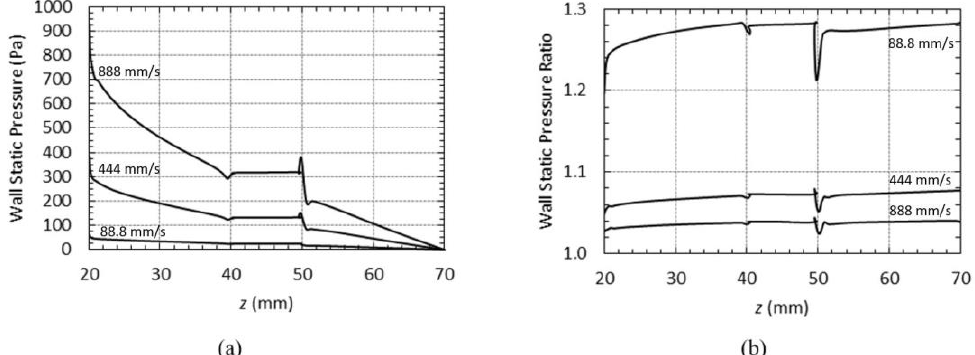
Figure 12. ( a ) Static pressure along the wall for Carreau model and different velocities. ( b ) Ratio between wall’s static pressure for Carreau and Newtonian models.